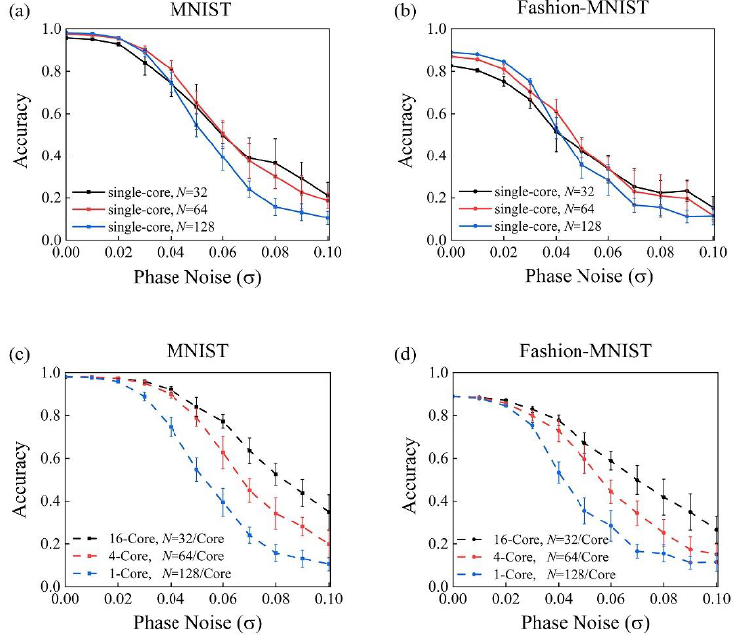
Figure 8. Phase noise robustness analysis of ( a , b ) the single-core PCNN and ( c , d ) the multicore PCNN on the MNIST and Fashion-MNIST test sets. The mean (square or circle) and standard deviations (short line) of classification accuracies change with phase noise changes.